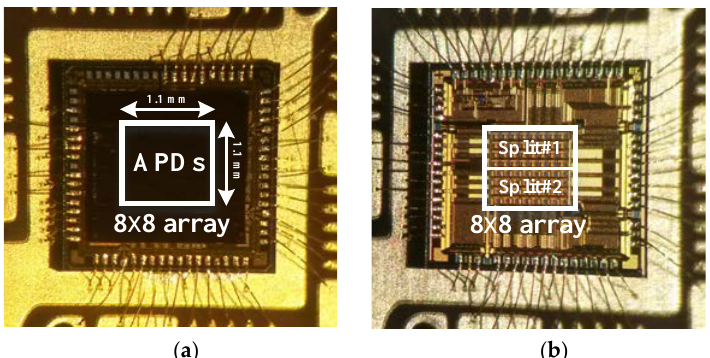
Figure 10. ( a ) Chip microphotograph with flip-chip and ( b ) without flip-chip-bonded avalanche photodiode (APD).